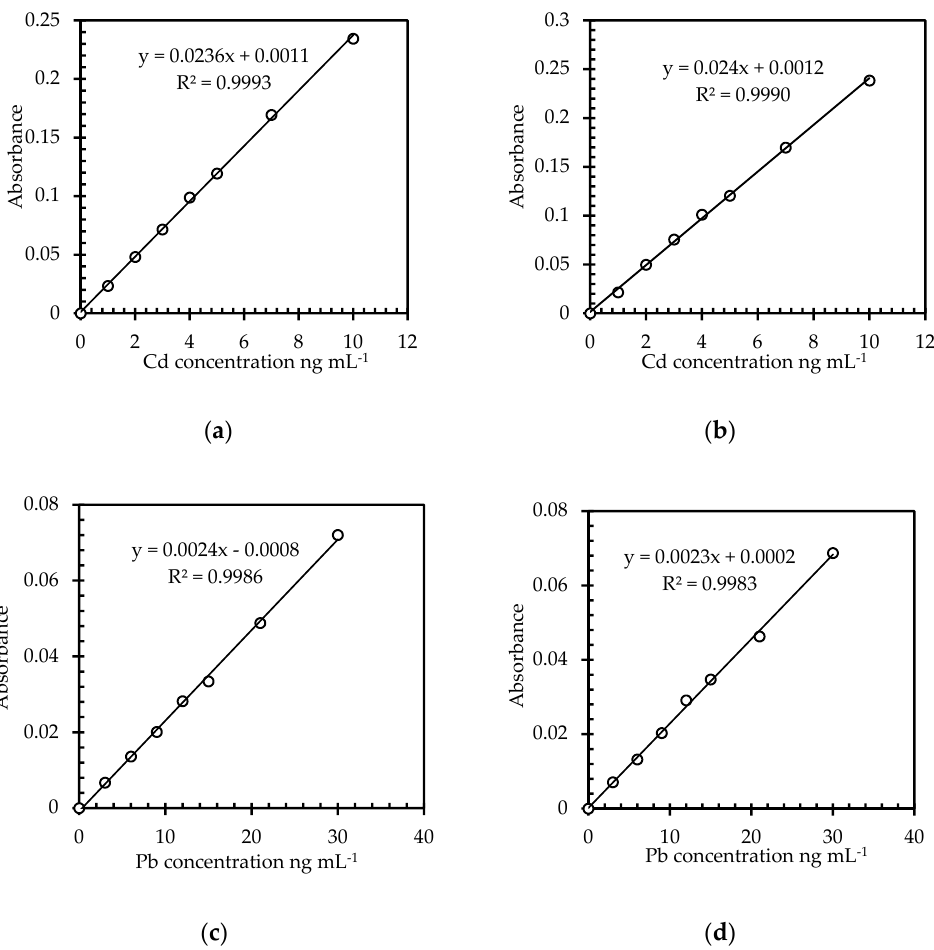
Figure 1. Calibration curves for Cd and Pb determination by graphite furnace atomic absorption spectrometry (GF-AAS): ( a ) Cd prepared in 0.5% ( m / v ) HNO 3 , ( b ) Pb prepared in 0.5% ( m / v ) HNO 3 , ( c ) Cd prepared in complex matrix that mimic the solution of digested samples, and ( d ) Pb prepared in complex matrix that mimic the solution of digested